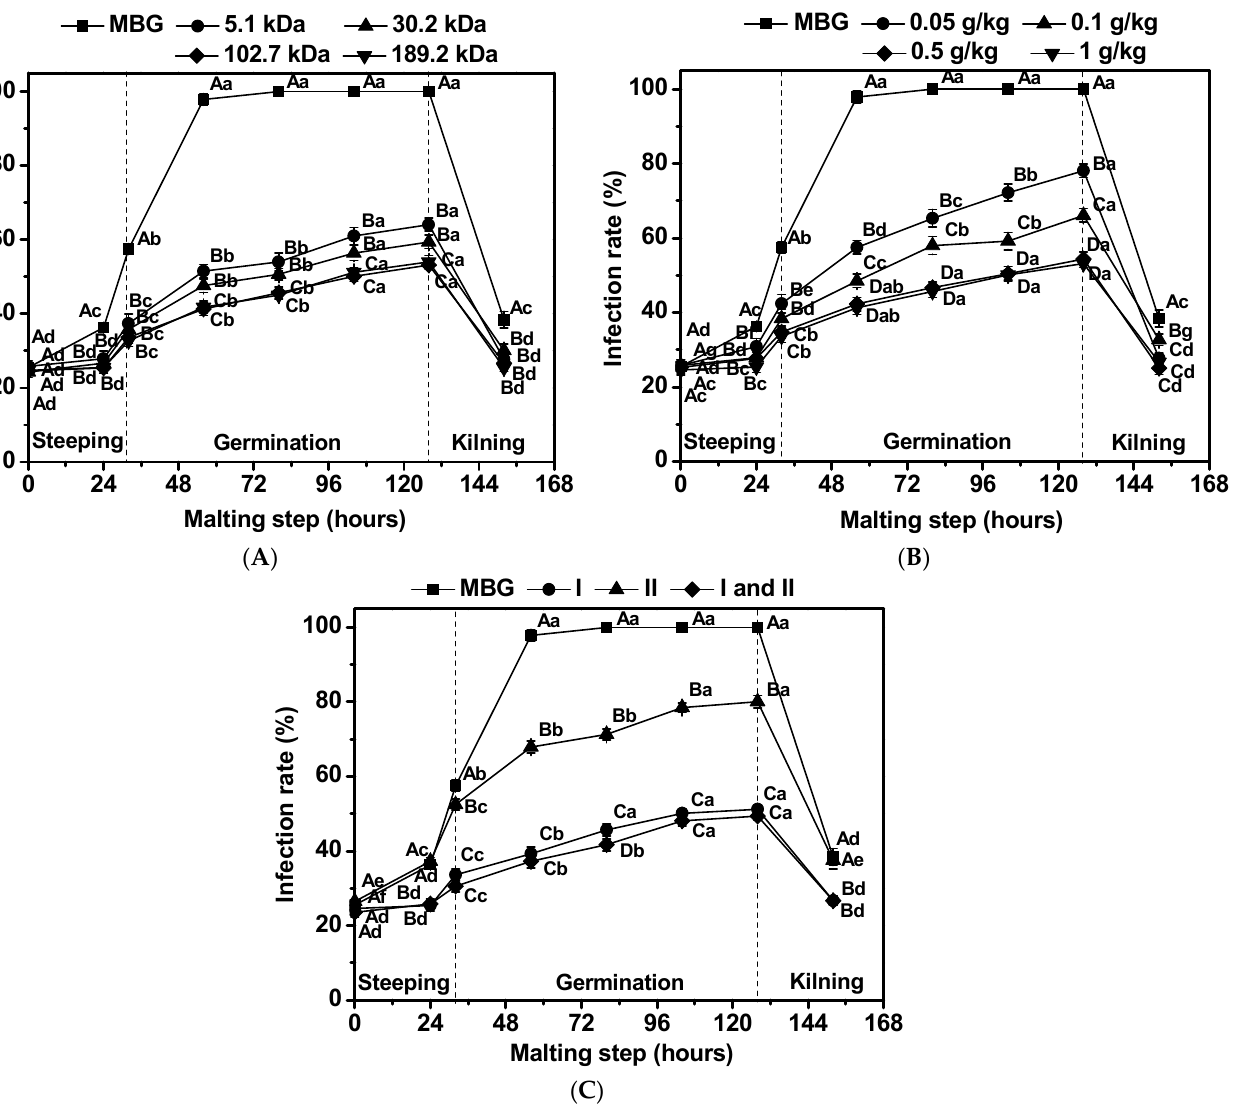
Figure 1. Effects of chitosan with different Mw ( A ), different concentrations ( B ), and different treatments ( C ) on Fusarium graminearum infection rate in barley during malting. Each number represents the mean ± standard deviation of three replicates. Within the same malting time and among different treatment conditions, different capital letter superscripts indicate significant differences ( p < 0.05); within the same treatment condition and among different malting times, different lowercase superscripts indicate significant differences ( p <0.05).